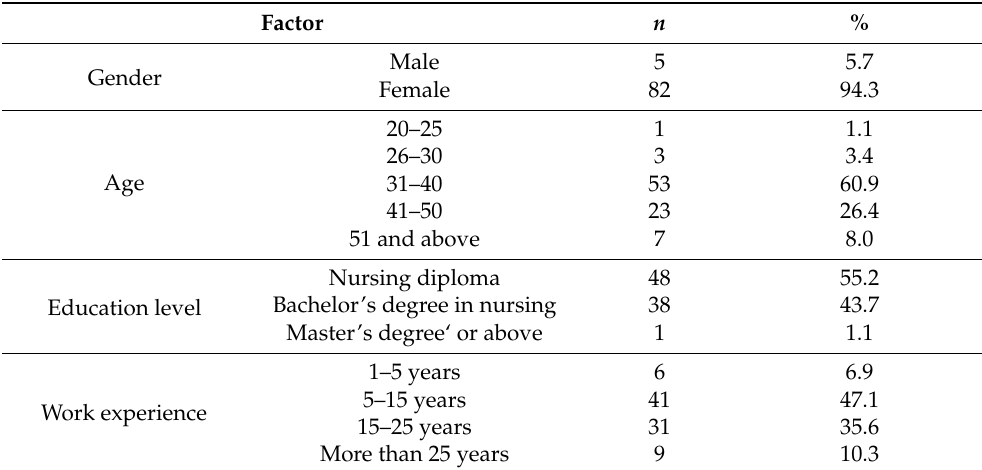
Table 1. Sociodemographic characteristics of the study’s participants.